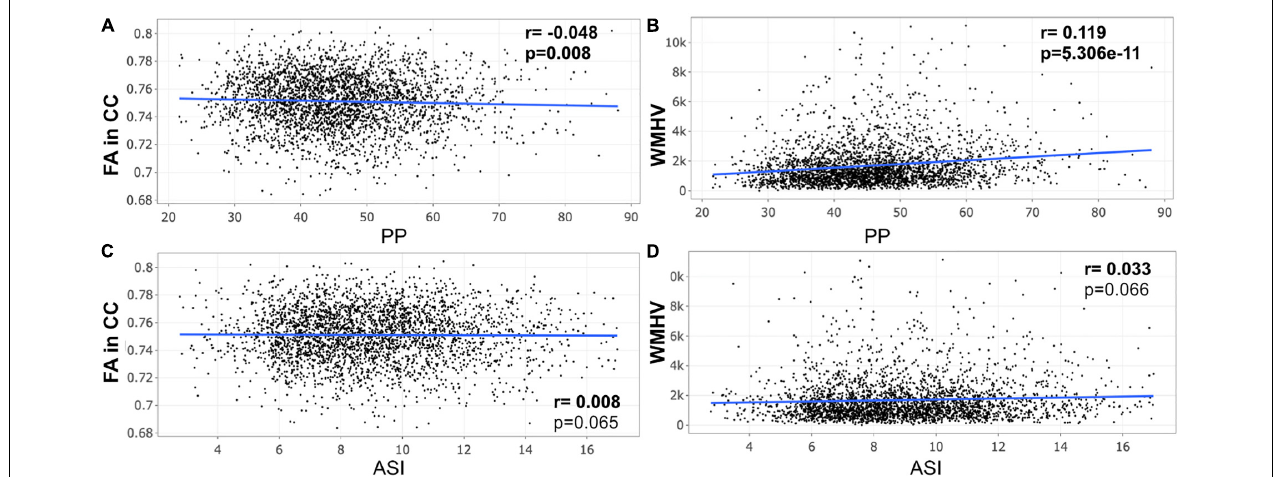
FIGURE 1 | Scatter plot for partial correlation analysis of either pulse pressure (PP) or arterial stiffness index (ASI) with the fractional anisotropy of the corpus callosum (FA in CC) or the white matter hyperintensity volume (WMHV) in 3,015 participants between 45 and 55 years old. Significant p -values are in bold (adjusted threshold with FDR was 0.025). Covariates included sex. An additional analysis was performed with both age and sex as covariates showing similar significant results: (A) p = 0.012; (B) p = 2.65e-09; (C,D) p >